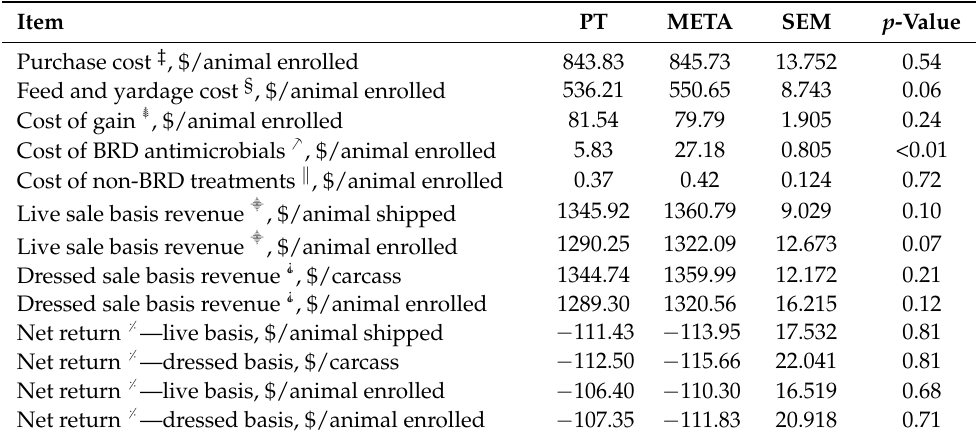
Table 5. Model adjusted means and standard errors of the mean (SEM) for economic outcomes from a partial budget assessment of steers and heifers at medium risk for bovine respiratory disease (BRD) that received metaphylaxis (META) or a pull-and-treat (PT) health program for BRD* †.